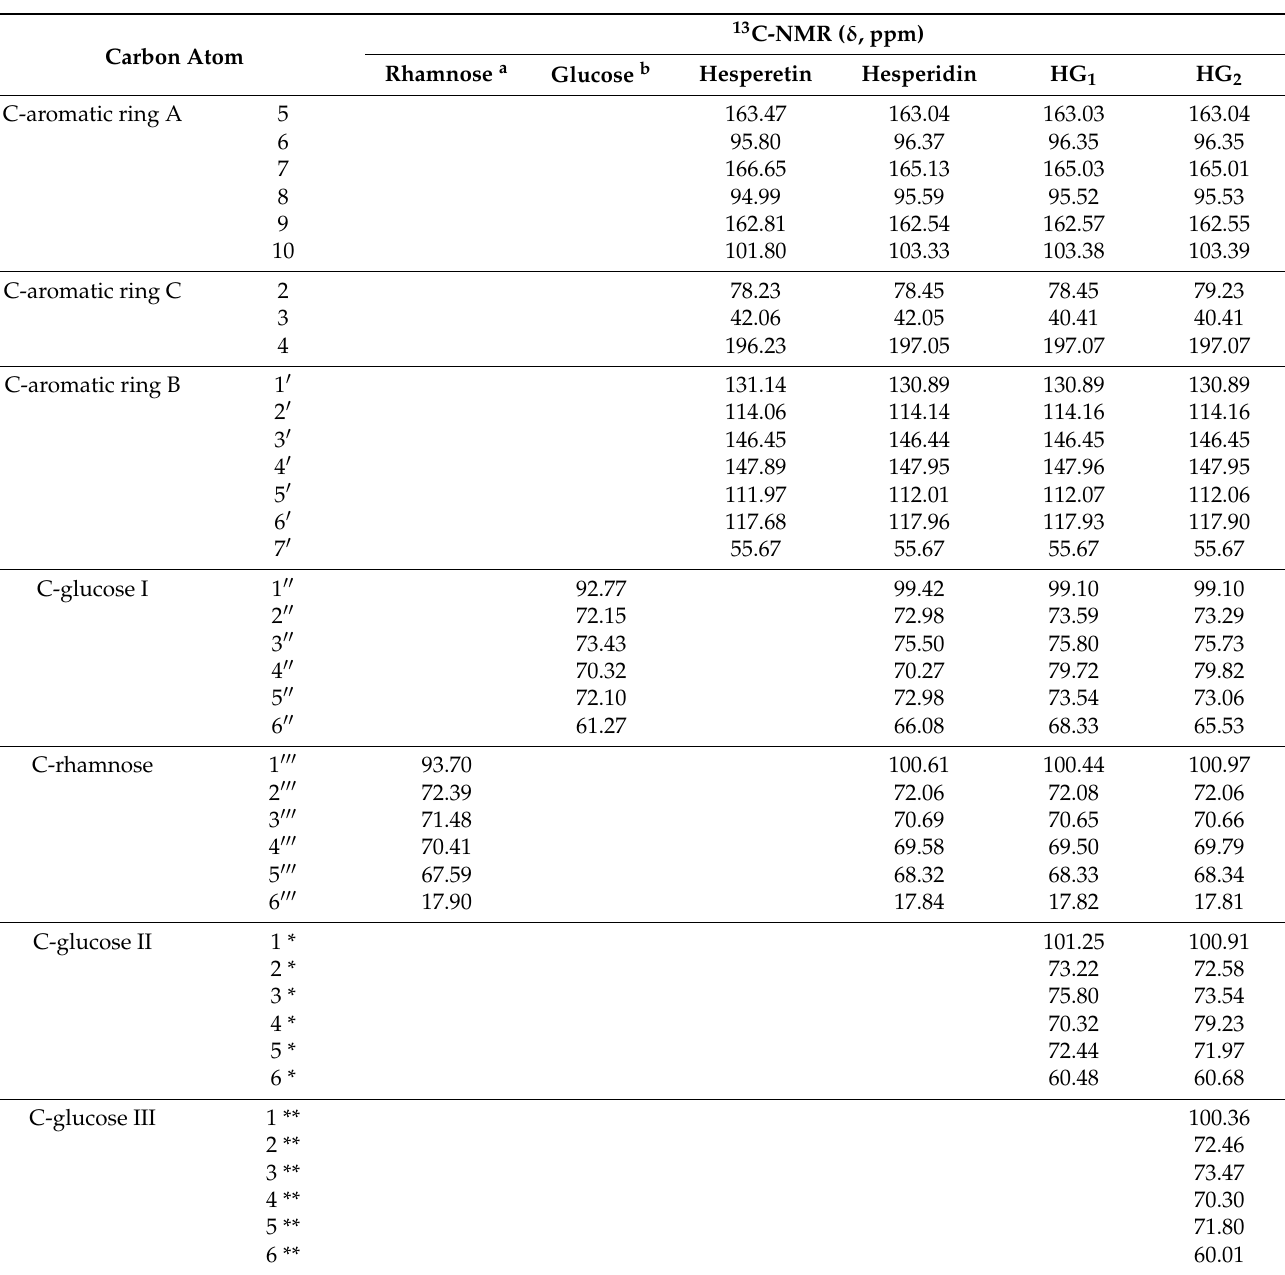
Table 1. 13 C-NMR analysis of hesperetin, hesperidin and HG